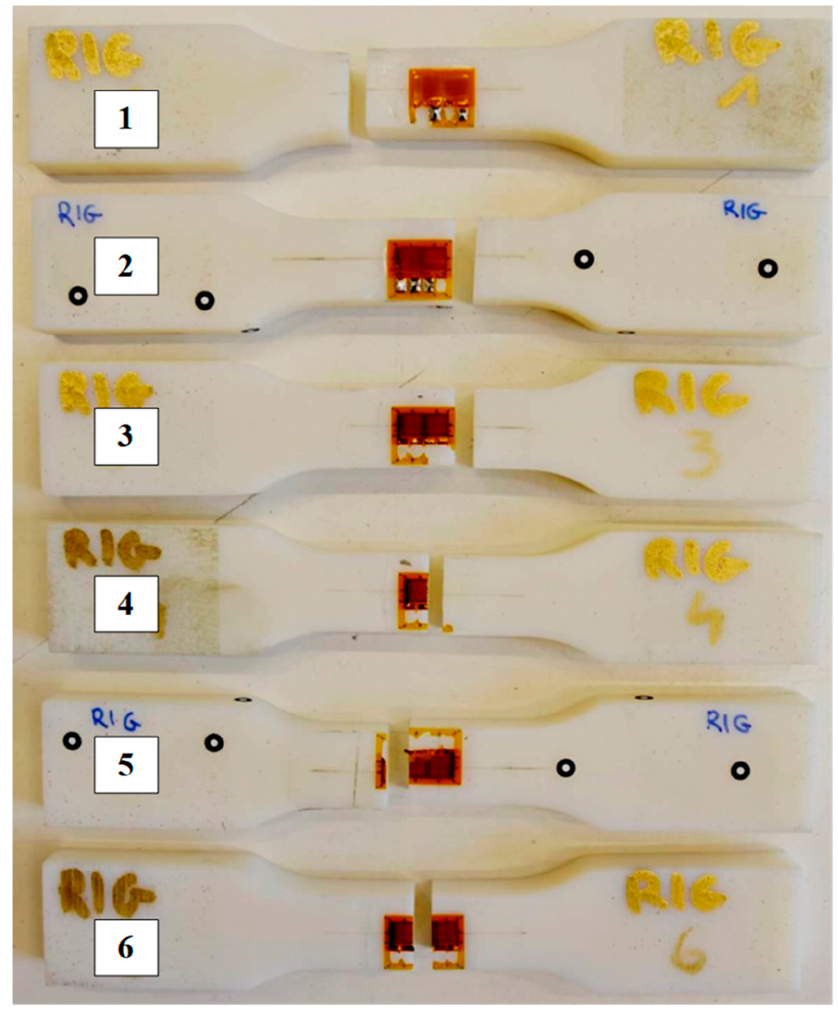
Figure 16. Six specimens made of Rigur material after tensile test, three (1–3) printed horizontally (X) and three (4–6) printed vertically